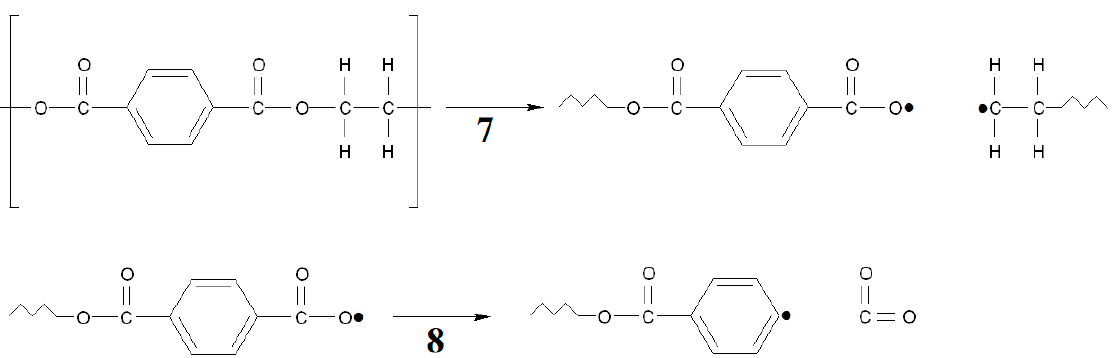
breaking of the C-O bond in PET between the carboxyl and ethylene groups; 8—CO 2 ; detachment Figure 15. Exemplary degeneration of PET. The following symbols were applied: 7—Homolytic breaking of the C ‐ O bond in PET between the carboxyl and ethylene groups; 8—CO 2 ; detachment with formation of phenyl with formation of phenyl radical.